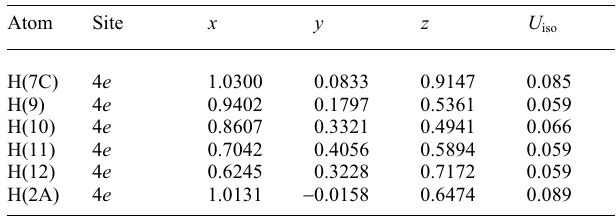
Table 2. Atomic coordinates and displacement parameters (in Å 2 )